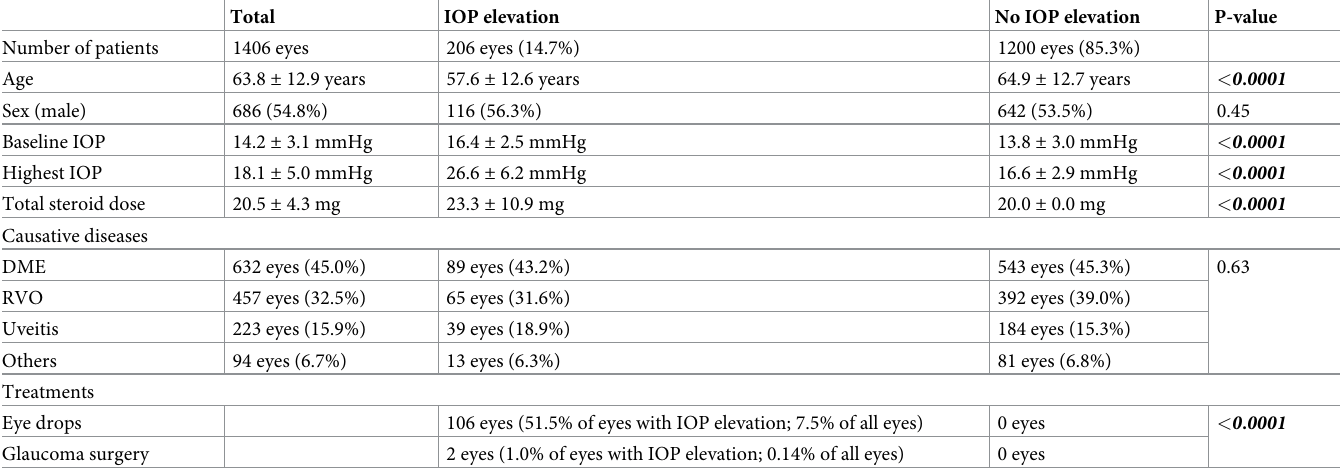
Table 2. Analyses of IOP elevation (IOP > 21